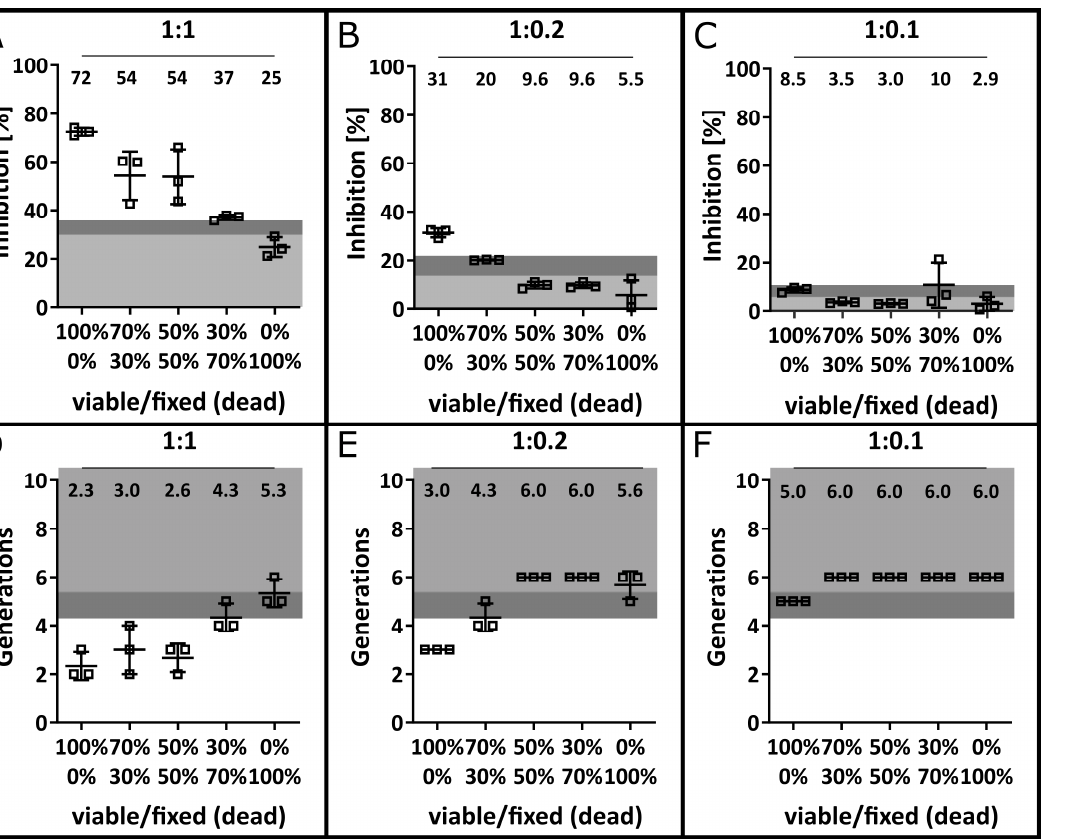
Figure 3. Specific inhibition of T cell proliferation by viable MSCs. MSCs were made non-functional with formalin fixation, mixed with vital MSCs at the indicated viable/fixed (dead) ratios and used in MLR co-cultures. The respective mean values of n = 3 independent experiments are indicated within each plot. Areas highlighted in light and medium grey mark the calculated LOD and LOB based on 100% dead MSCs in the respective concentration. The inhibition of T cell proliferation was determined in the presence of MSCs after co-culture in a 1:1 ratio ( A ), in a 1:0.2 ratio ( B ) and in a 1:0.1 ratio ( C ). Additionally, the number of T cell generations is displayed after co-culture with MSCs in a 1:1 ratio ( D ), a 1:0.2 ratio ( E ) and a 1:0.1 ratio ( F ) with the LOB and LOD defined by Figure 4.